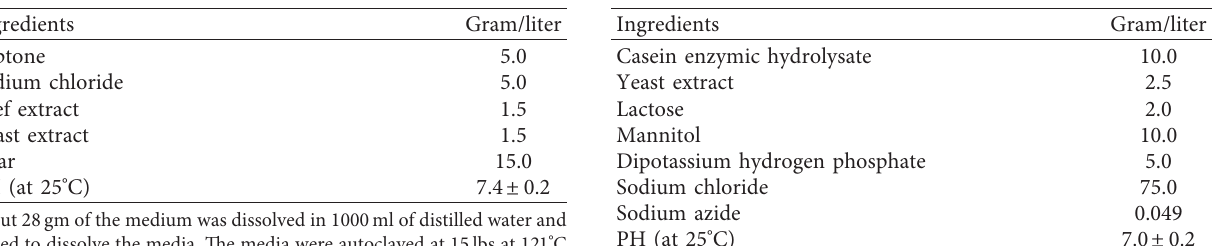
Table 5: Ingredients used in gram/liter in the preparation of nutrient agar.